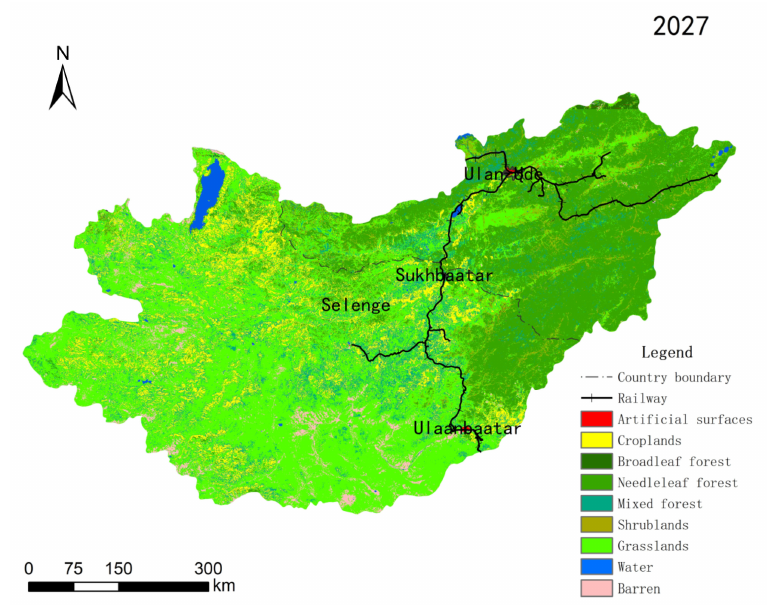
Figure 16. Land use prediction in the 2027 Selenga River